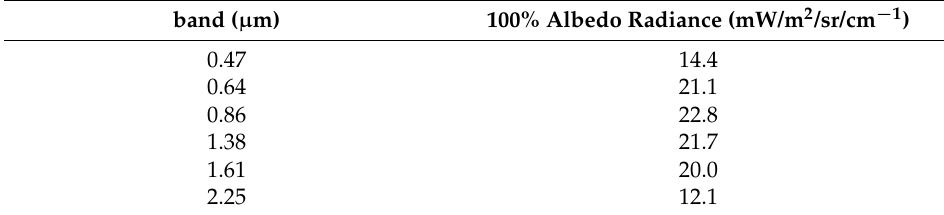
Table 3. The 100% albedo at the nominal center wavelengths of